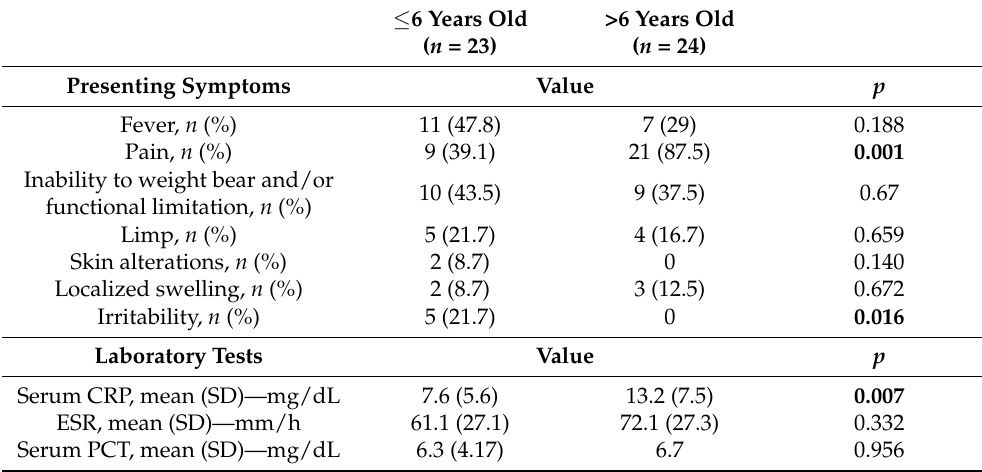
Table 1. Comparison of presenting symptoms and laboratory tests in the two different age